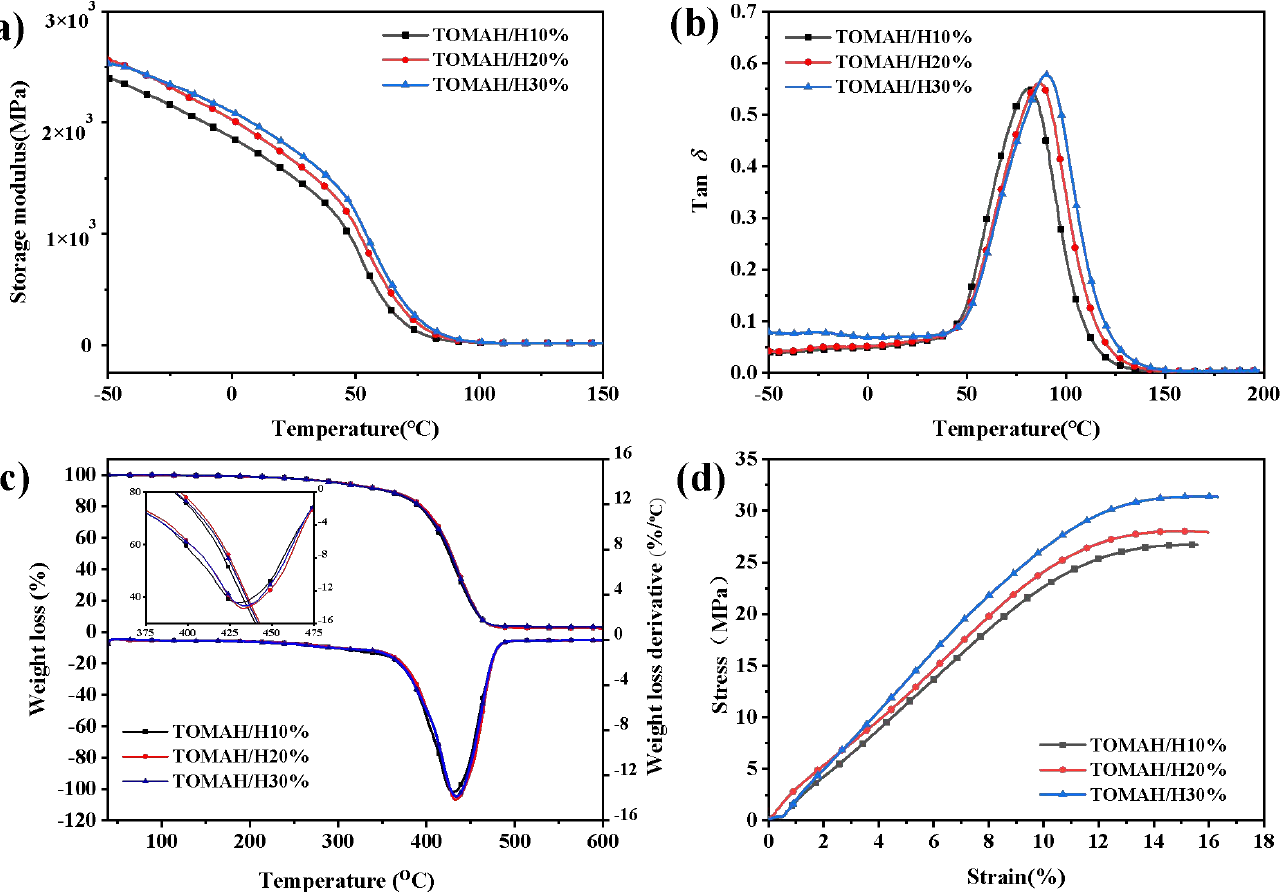
Figure 3. ( a ) Storage modulus, ( b ) loss factor, ( c ) TGA curves and their derivatives, and ( d ) typical stress–strain curves of the cured TOMAH/H materials. Table 3. Thermal properties of the cured TOMAH/H materials.